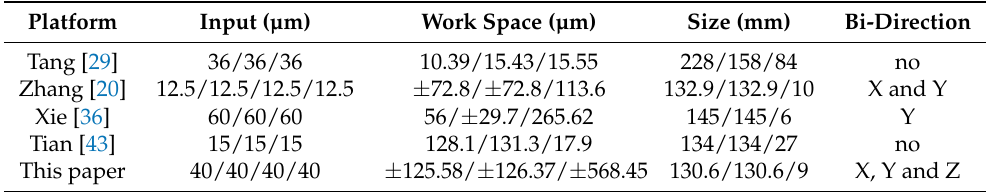
Table 5. Comparisons of 3DOF XYZ